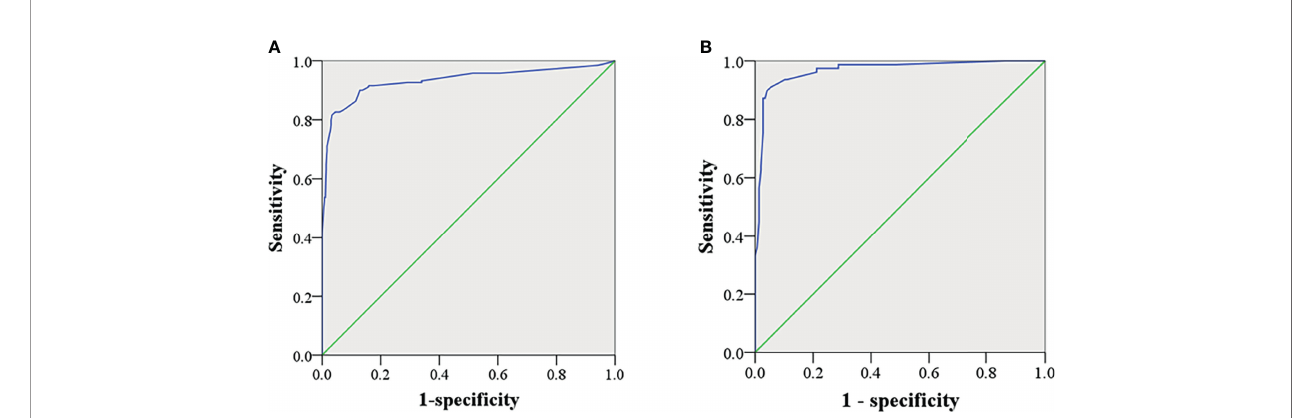
FIGURE 2 | ROC of the test and validation set. The AUC was 0.933 (95%CI: 0.905-0.960, p < 0.001) and 0.967 (95%CI: 0.943-0.991, p < 0.001) in the training (A) and the internal validation set (B) ,